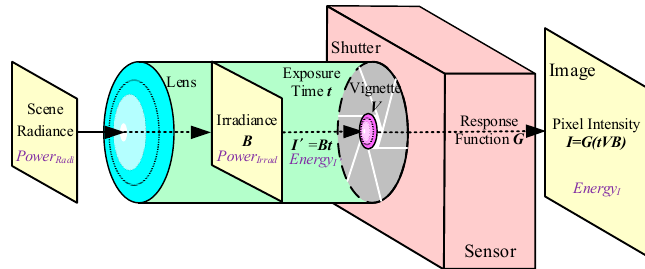
Figure 2. The flow chart of photometric image formation. The original energy that is emitted from the scene, which is called the radiance, is affected by the vignetting effort of the lens and the exposure time of the shutter.